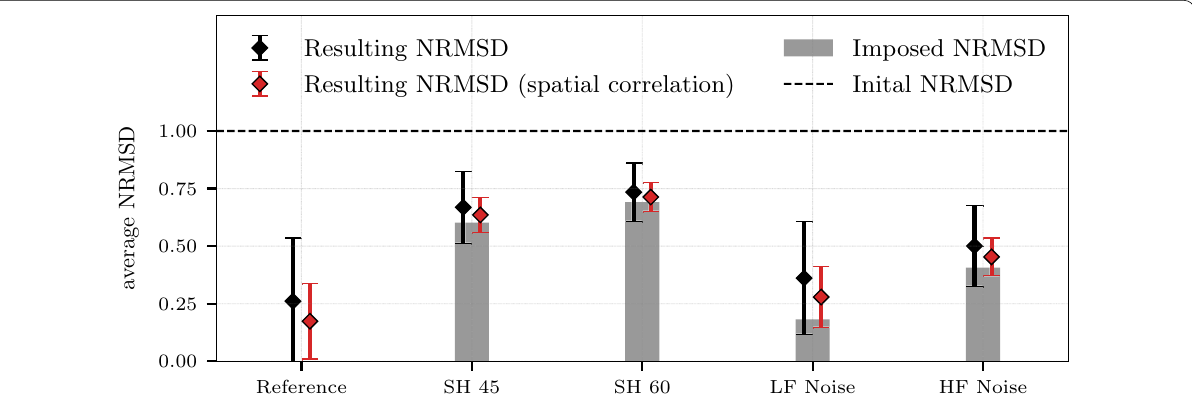
Fig. 12 This plot summarizes the assimilation results of test case scenario B. The NRMSD averaged over the ocean is shown for several cases with deviating true OIMF. The References denote the results from the ideal test case. Both results from assimilation without (black) and with (red) the use of an a priori spatial correlation are shown. The corresponding uncertainty resulting from the posterior STD of the scale factor is indicated as well. As a comparison, the imposed NRMSD (deviations between imposed and true OIMF anomalies) are marked in grey. These indicate the best achievable results and are considered a lower limit of possible